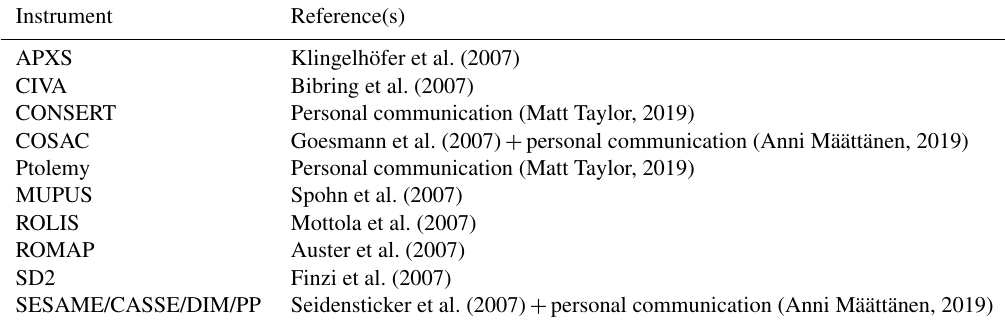
Table A3. Philae’s instruments and references for team members